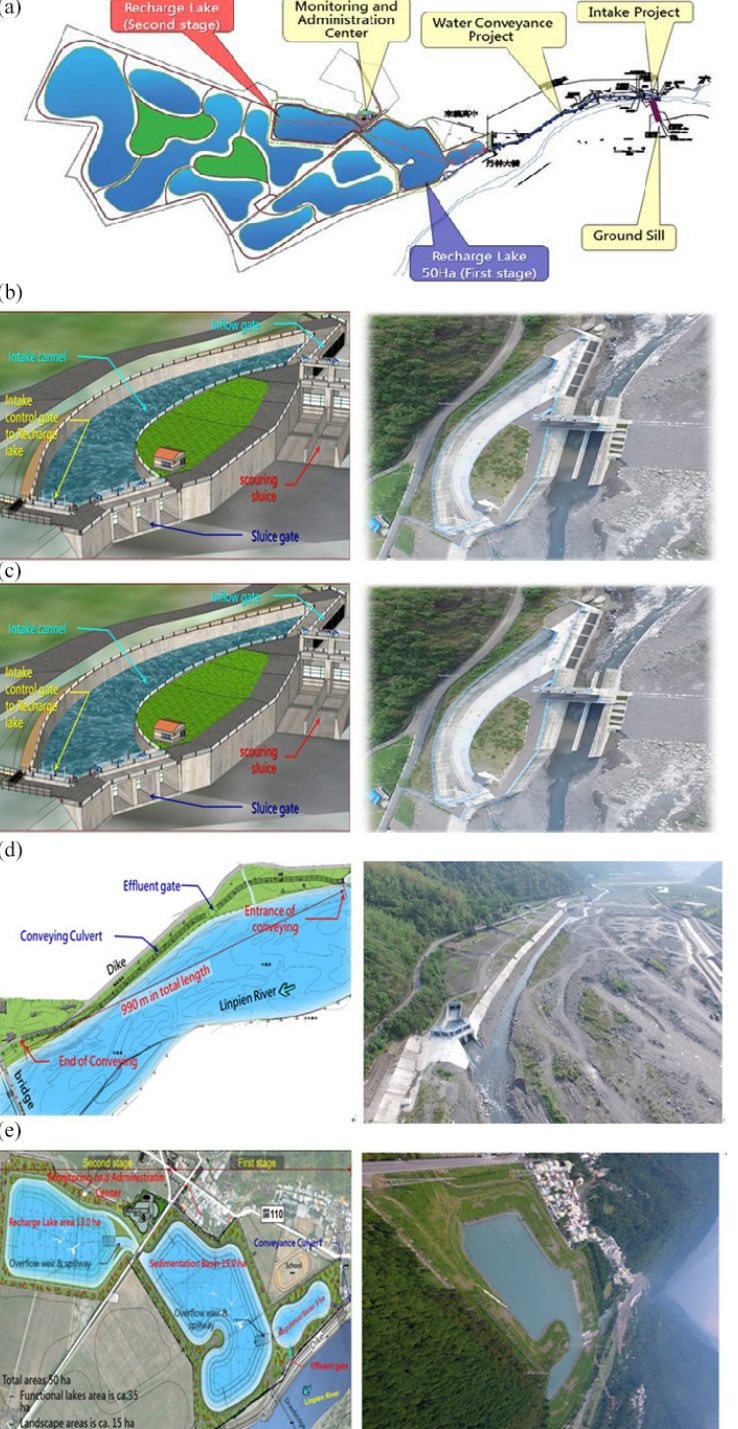
Figure 4. Engineering works of the Artificial Recharge of Groundwater Project (Pingtung County Government, 2010). (a) Engineering works map of the Artificial Recharge of Groundwater Project (Pingtung County Government, 2010). (b) Intake works and ground sill of the Artificial Recharge of Groundwater Project (Pingtung County Government, 2010). (c) Intake works of the Artificial Recharge of Groundwater Project (Pingtung County Government, 2010). (d) Water conveyance channel of the Artificial Recharge of Groundwater Project (Pingtung County Government, 2010). (e) Sedimentation basin (pond) of the Artificial Recharge of Groundwater Project (Pingtung County Government,